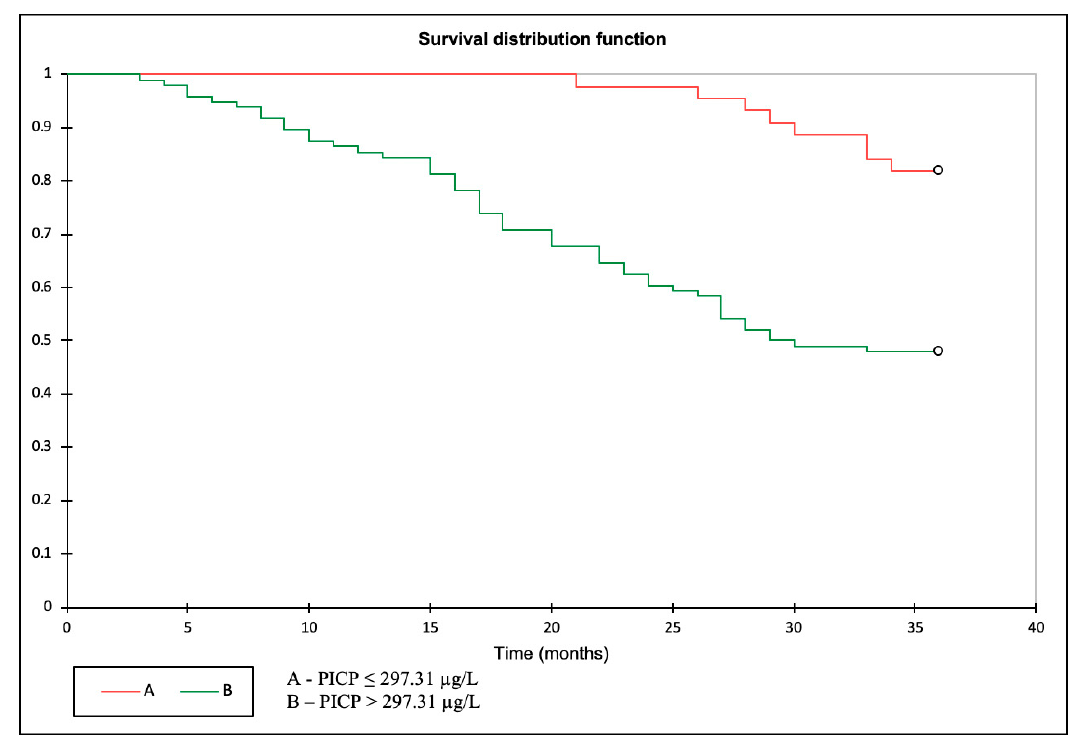
Figure 1. Kaplan–Meier curve displaying the impact of PICP levels on all-cause mortality.